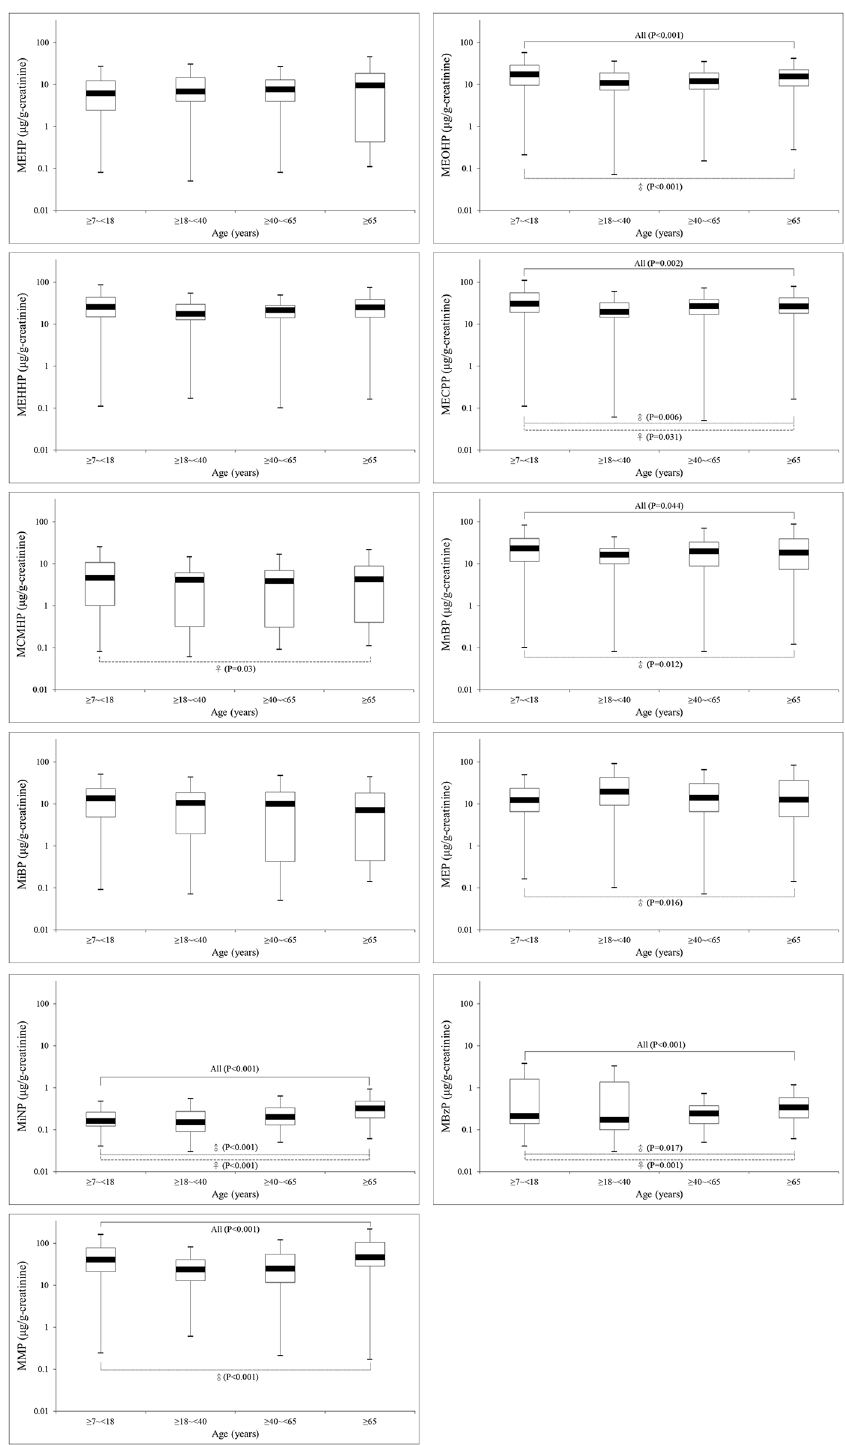
Fig 3. Distribution of 11 phthalate metabolites in a sample of the general Taiwanese population (N = 387) by age groups (solid line inside the box plot: median).